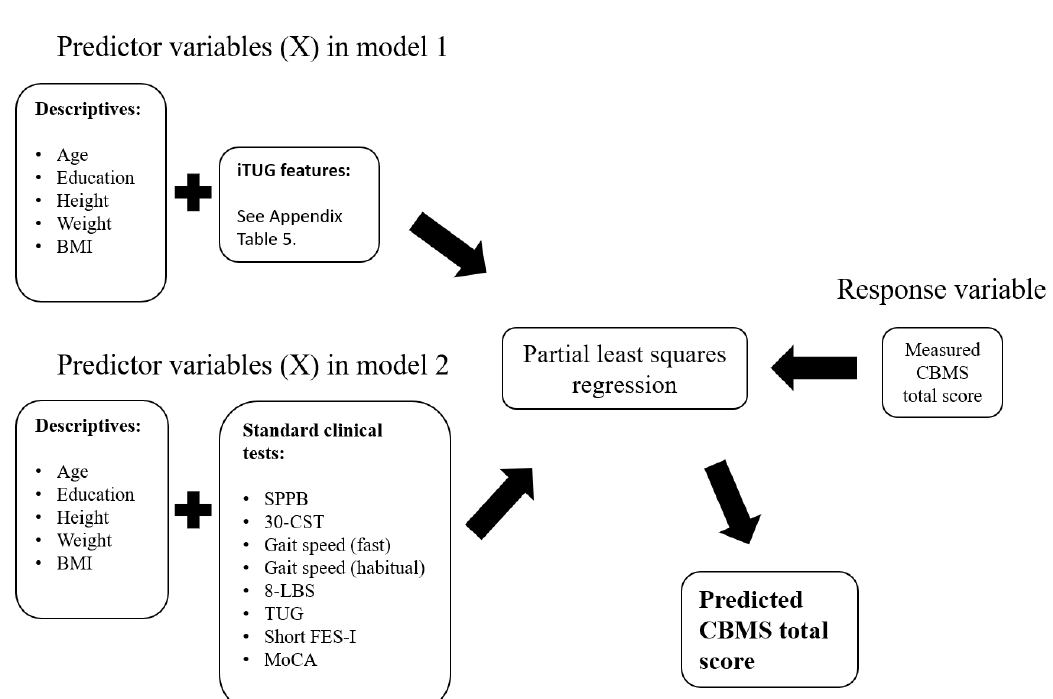
Figure 3. Schematic presentation of the data that were used as predictor and response variables in the two separate partial least squares regression (PLSR) models presented in this paper. Model 1 included descriptive data and iTUG features, while model two included descriptive data and standard clinical tests. The Community Balance and Mobility Scale (CBMS) scores was used as a response variable.